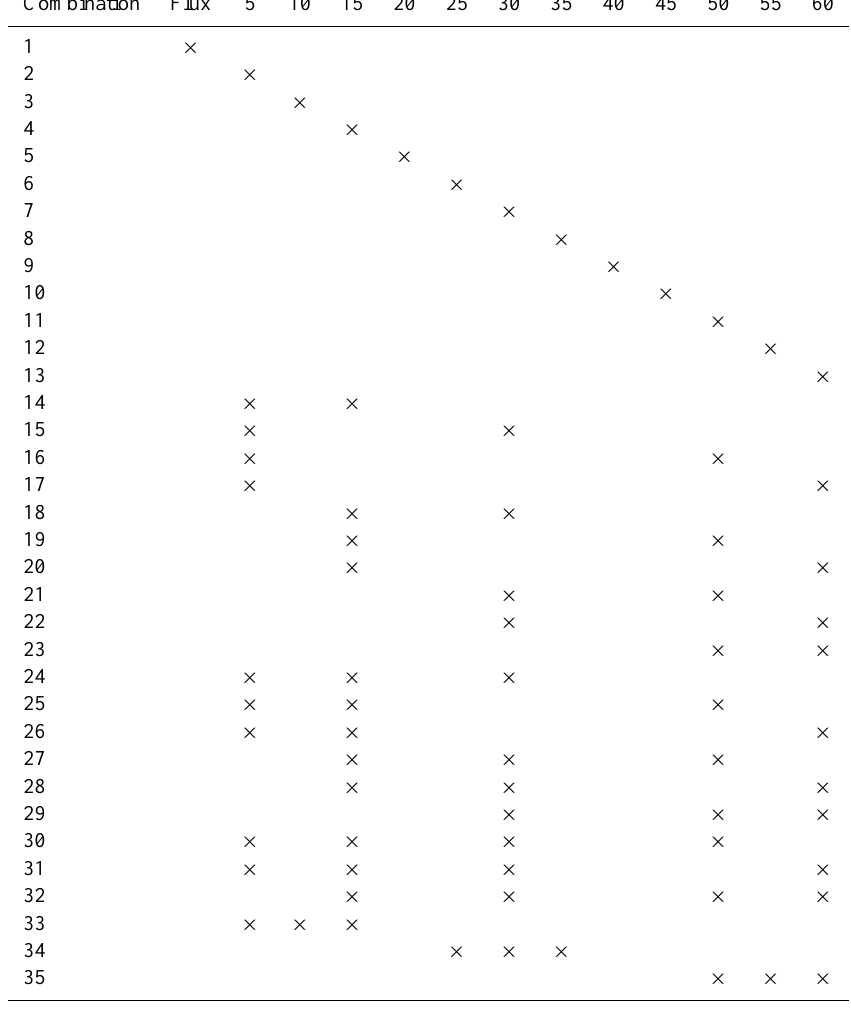
Table 2. Measurement combinations used for the simulations. The combination number is listed at the beginning of each row. The columns represent the type of measurement (e.g. CO 2 surface flux), or the depth of concentration measurement in centimetres. The “ × ” values denote whether the type or depth of measurement was included in the combination.